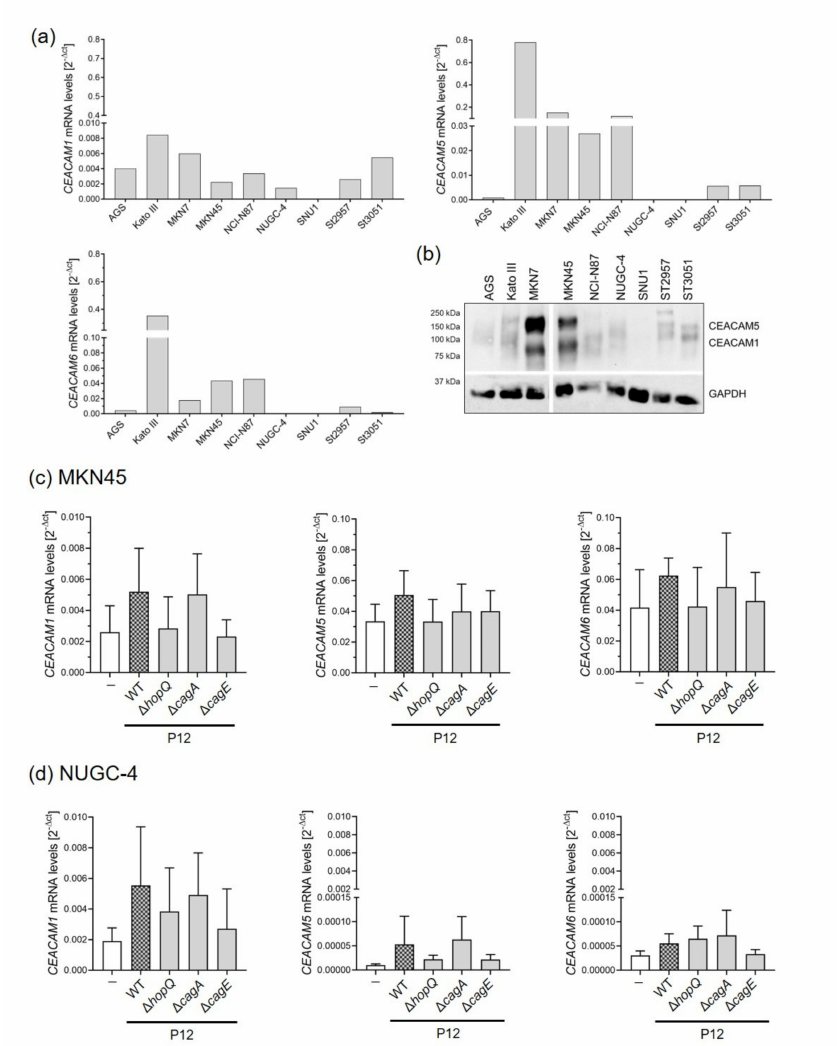
Figure 2. CEACAM expression levels are upregulated upon H. pylori infection. Different gastric cancer cells were screened for basal CEACAM1 , 5 and 6 mRNA ( a ) and protein ( b ) expression by qPCR and Western blot, respectively. MKN45 ( c ) and NUGC-4 ( d ) cells were infected with P12 wild type H. pylori strain, or isogenic mutant strains, at an MOI of 10 for 8 h. CEACAM1 , 5 and 6 mRNA levels were analyzed by qPCR. GAPDH was used as a housekeeping gene. All qPCR values were normalized to GAPDH and calculated using the 2 − ∆ ct equation. Graphs show mean ± SD of at least three independent experiments. One-way ANOVA with Bonferroni correction was used to test differences between